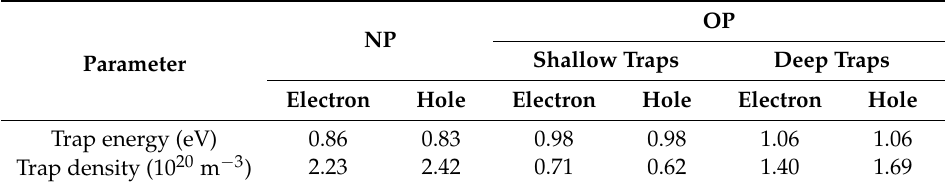
Figure 6. Measured ISPD curves and the corresponding calculated energy distribution: ( a ) Time dependent surface potential; ( b ) electron trap energy distribution; ( c ) hole trap energy distribution. Table 3. Estimated traps parameters of OP and NP.